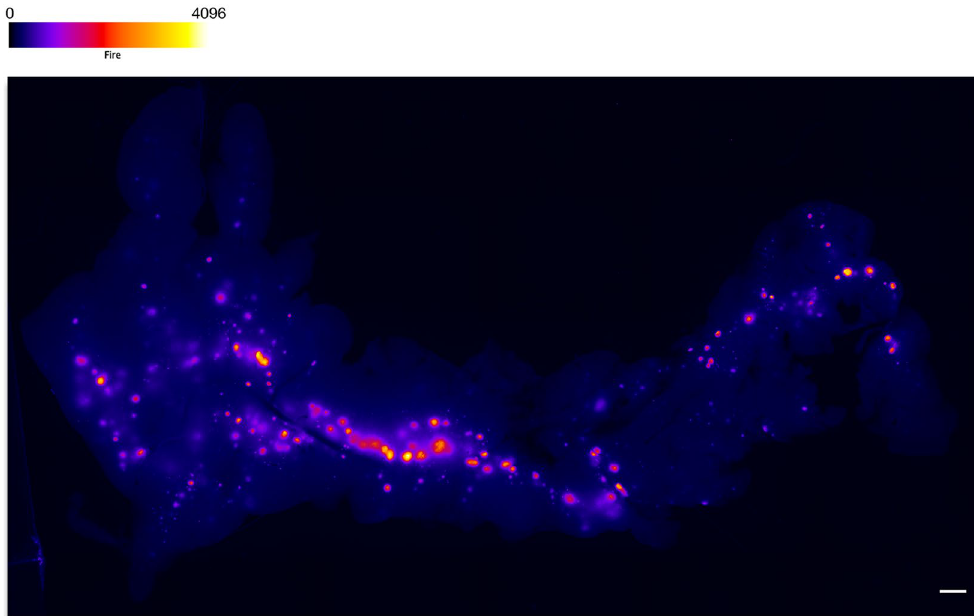
Figure 8. Excised pancreas from a CpepSfGFP mouse. Fluorescence imaging with intensity-based “Fire” pseudocoloring (scale on top) of an excised pancreas from a CPepSfGFP mouse. The tail of the pancreas is on the left and the head on the right. Scale bar 1